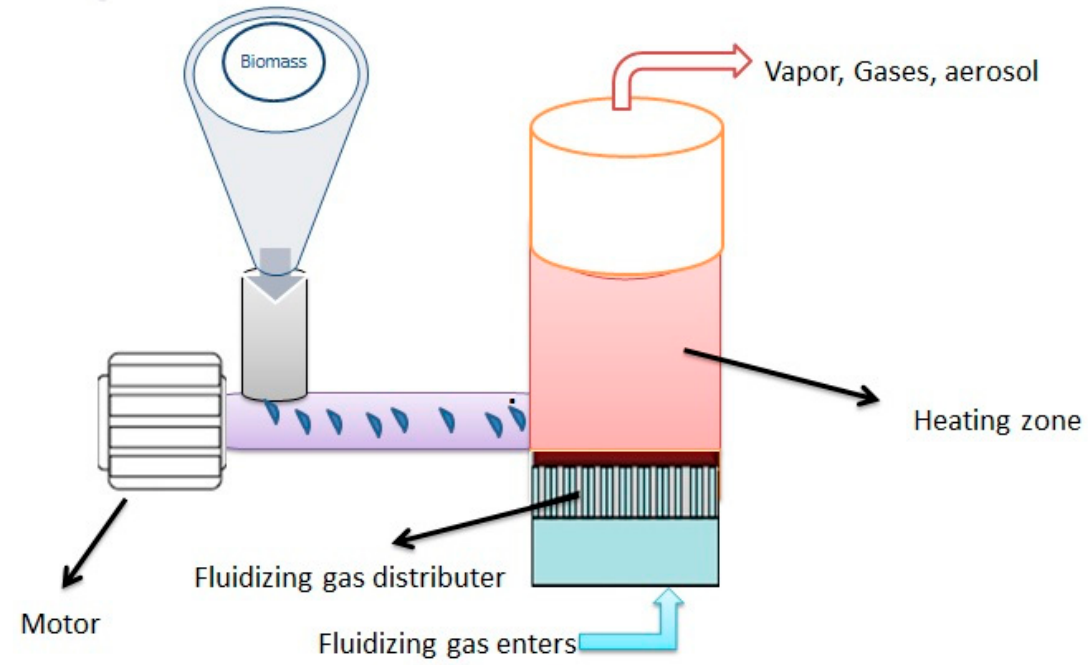
Figure 3. Diagram of a fluidized bed reactor typically used in the production of biochar with the fast pyrolysis process.